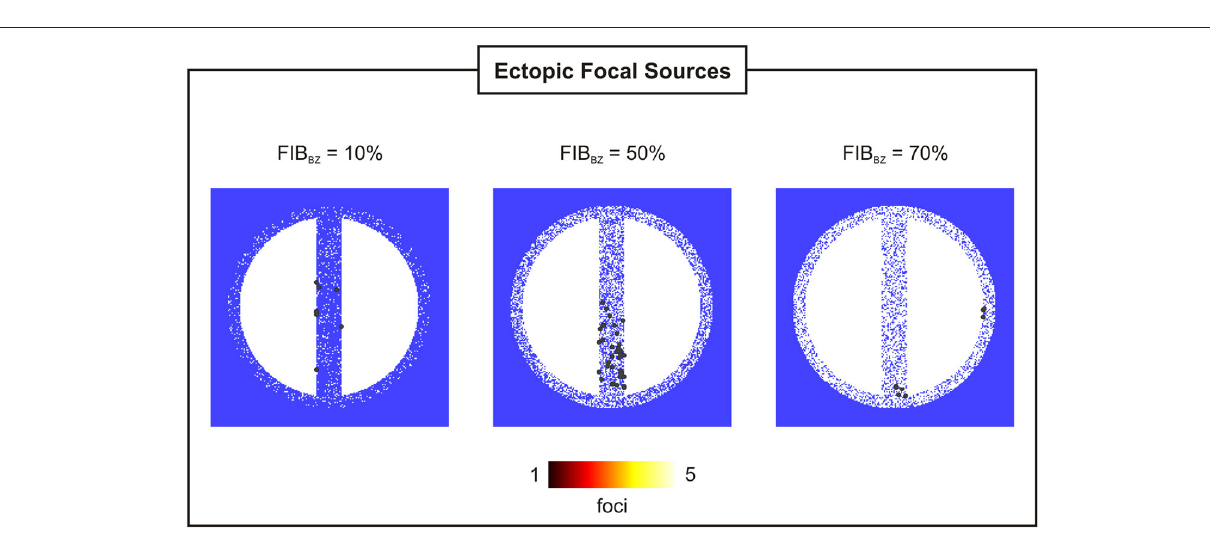
FIGURE 9 | Location and incidence of PVCs in 2D sheets with w isth = 4mm and FIB BZ = 10, 50, and